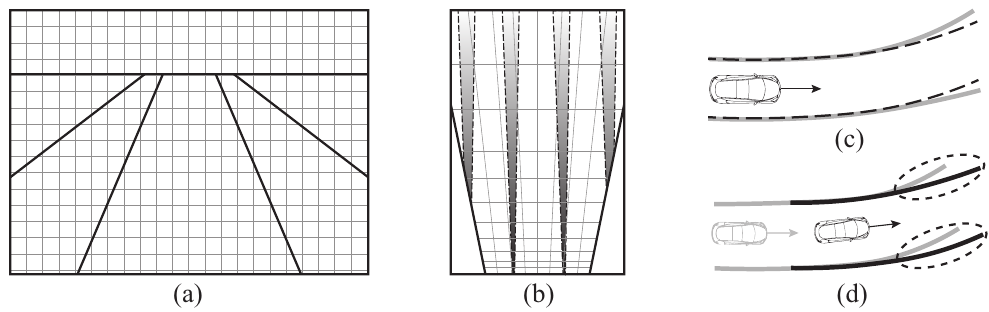
Figure 3. Potential error sources when using lane detection for vehicle localization: ( a ) Original road image in perspective view; ( b ) Blurred lane estimation accuracy along preview distance in global frame; ( c ) Effects of vehicle attitude and road inclination in lane detection result; ( d ) Mismatched lane lines in successive